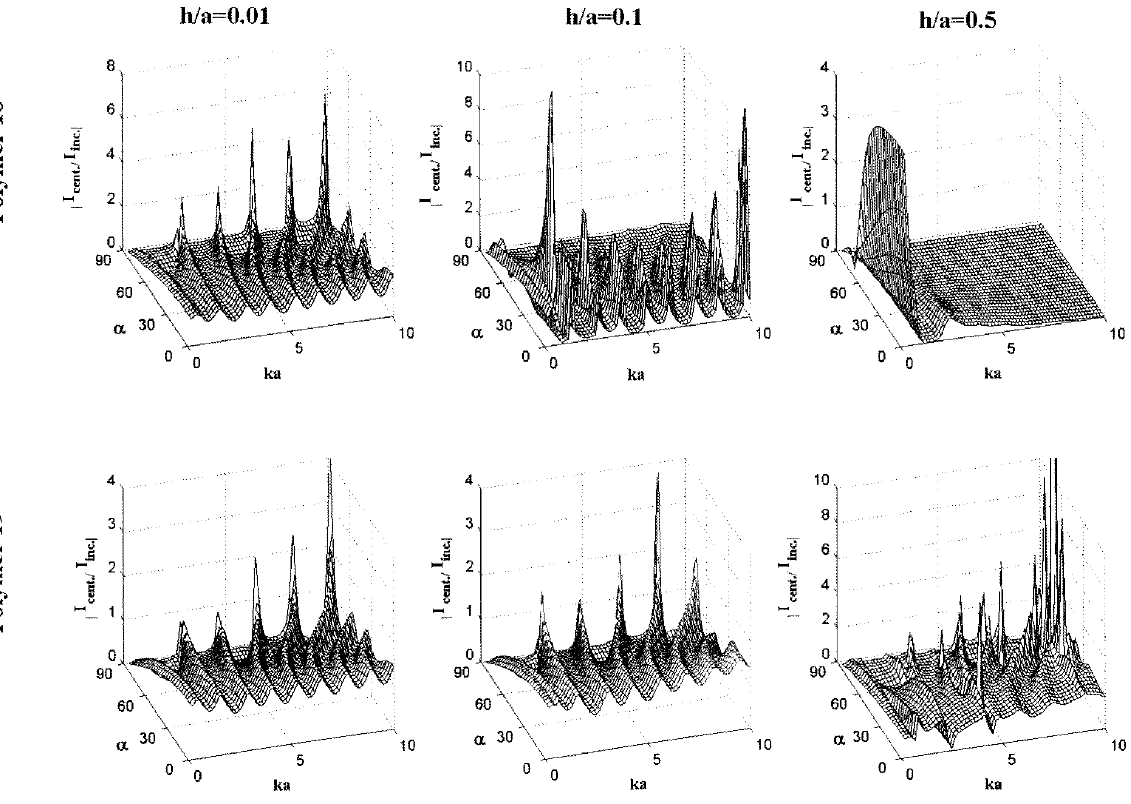
Fig. 11. Transmitted acoustic intensity at the center of the fluid-filled viscoelastic cylindrical shell per unit incident wave intensity versus nondimensional frequency and angle of wave incidence for selected shell